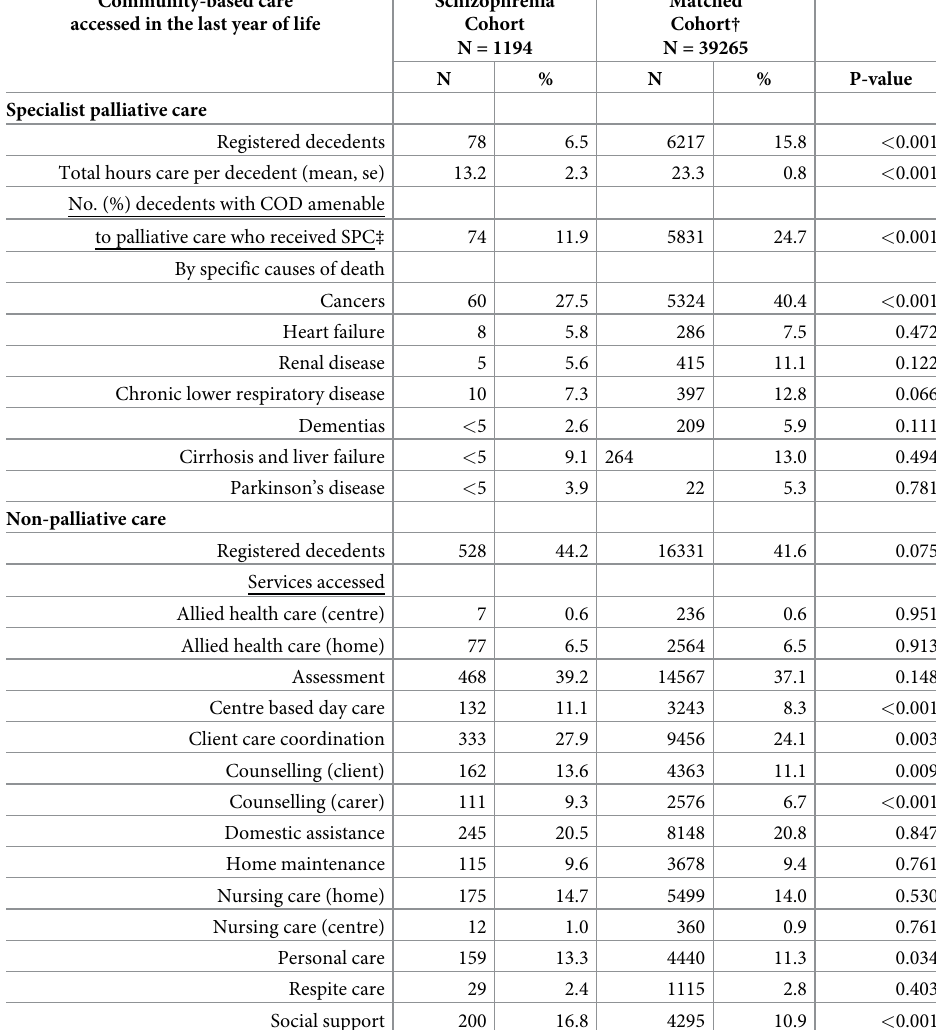
Table 6. Summary of community-based non-palliative and specialist palliative care accessed in the last year of life by the schizophrenia and matched cohorts. Community-based care Schizophrenia accessed in the last year of life